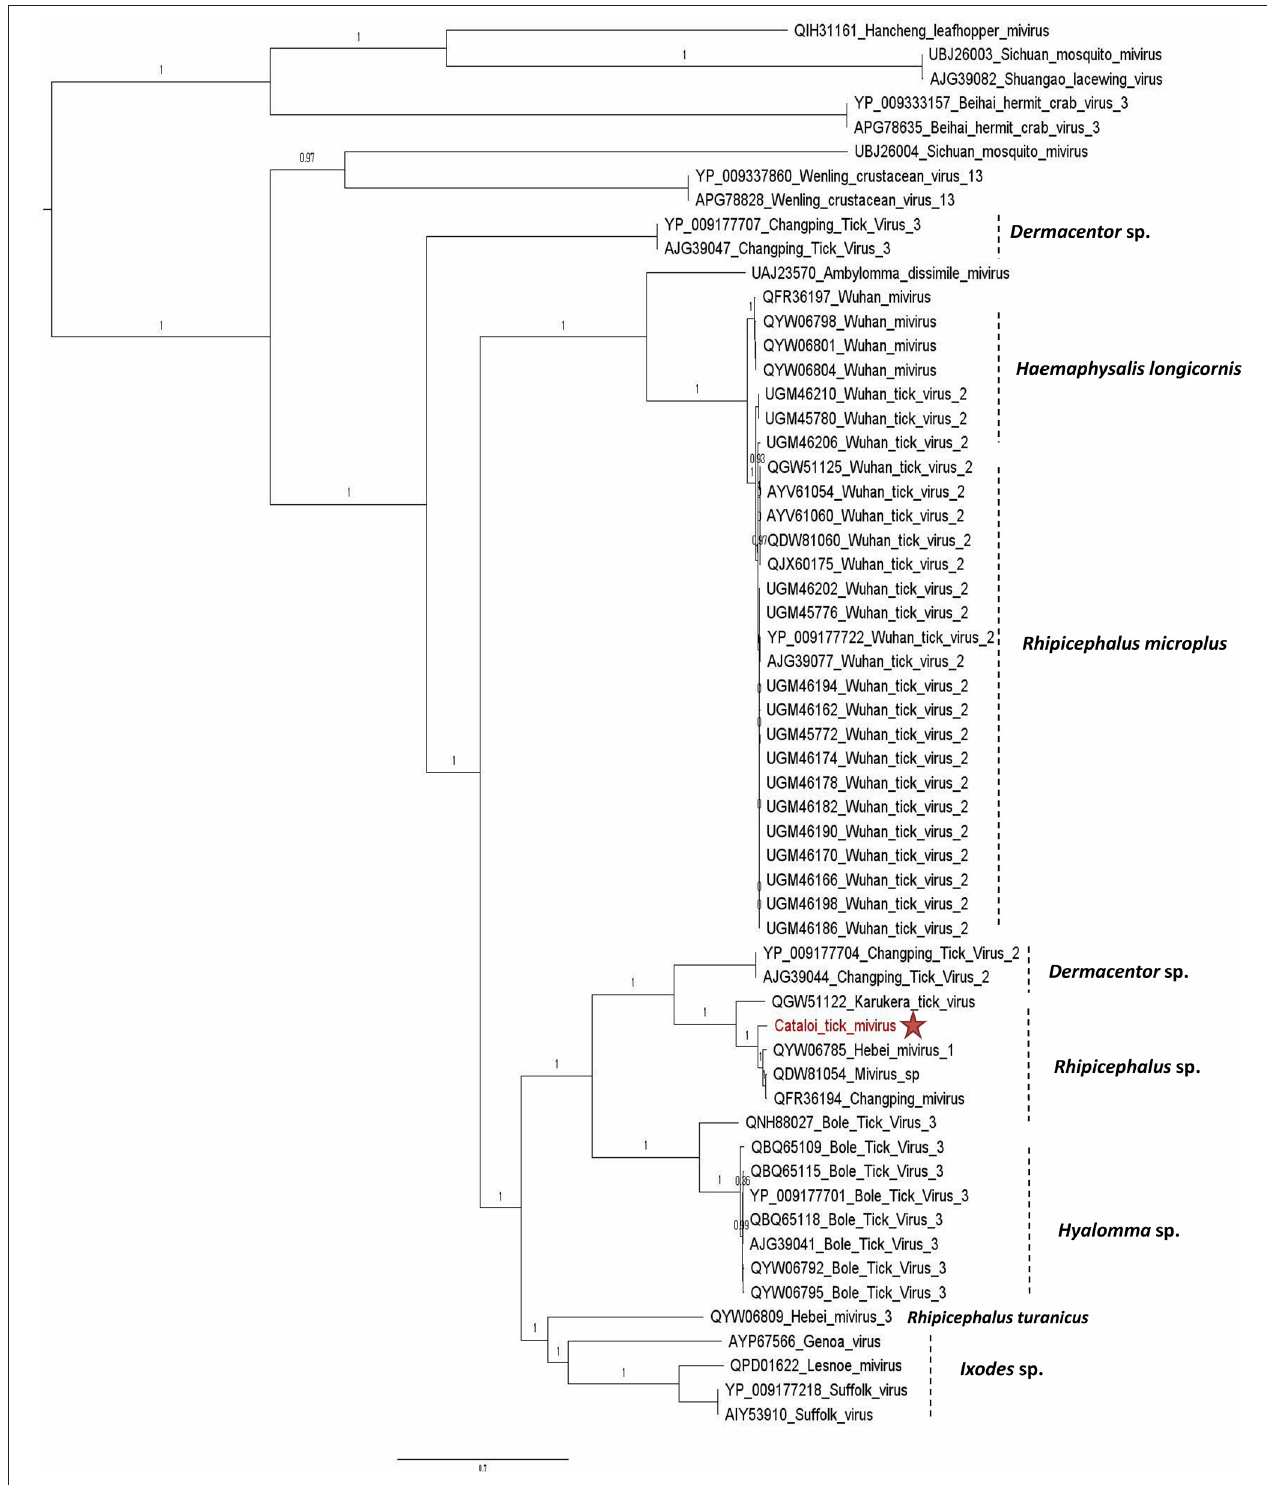
FIGURE 2 | Phylogenetic relationship of RNA-dependent RNA polymerase of Cataloi mivirus (CTMV) identified in Romanian Rhipicephalus ticks with other viruses among the Chuviridae family.